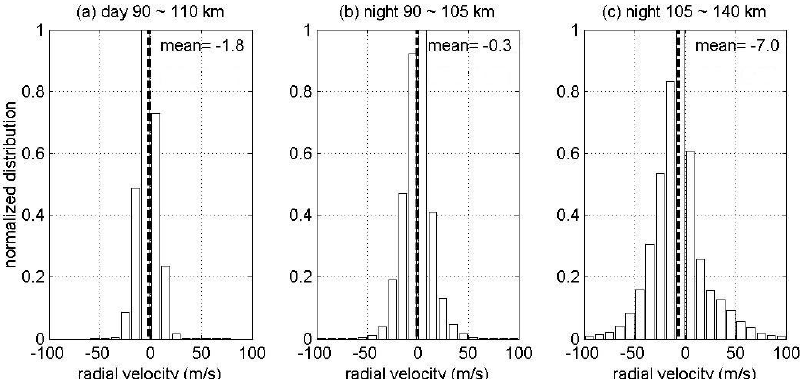
Fig. 4. The histograms of the mean radial velocity of the echoes for three categories: (left) daytime FAI echoes at 90–110km range, (central) nighttime FAI echoes at 90 to 105km range, and (right) nighttime FAI echoes at 105 to 140km range.